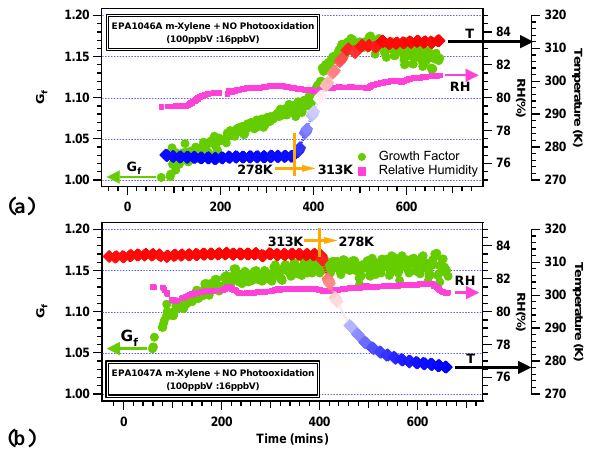
Fig. 3 Growth factor and RH for m -xylene photooxidation experiments at two different temperatures.